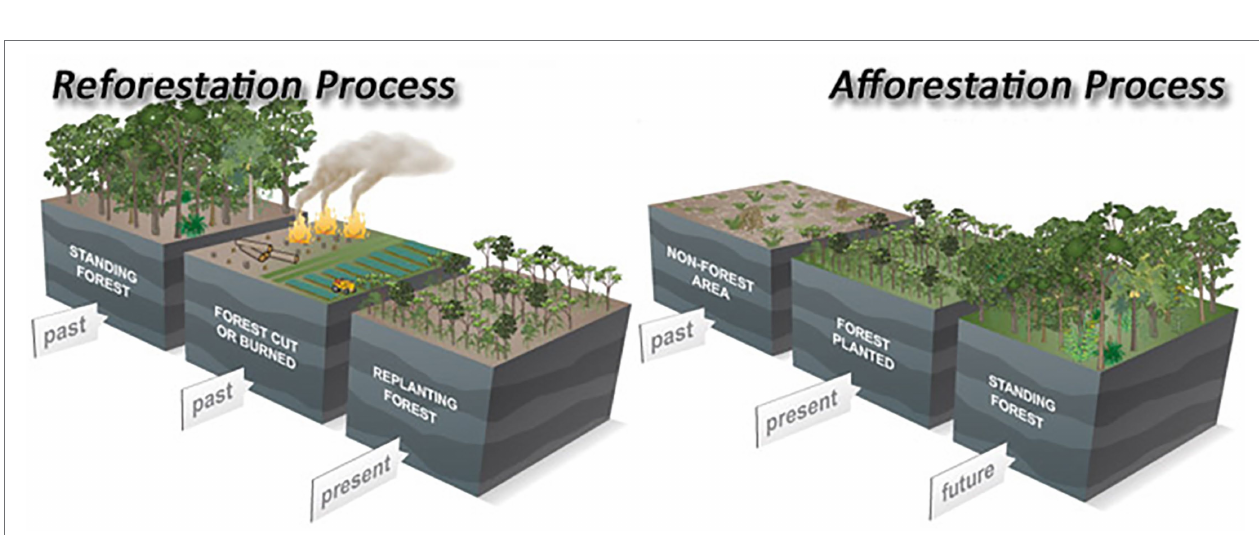
FIGURE 2 | Image to differentiate reforestation from afforestation . Source : Geoengineering Inquiries. Reproduced with permission from Ken Caldeira, available at